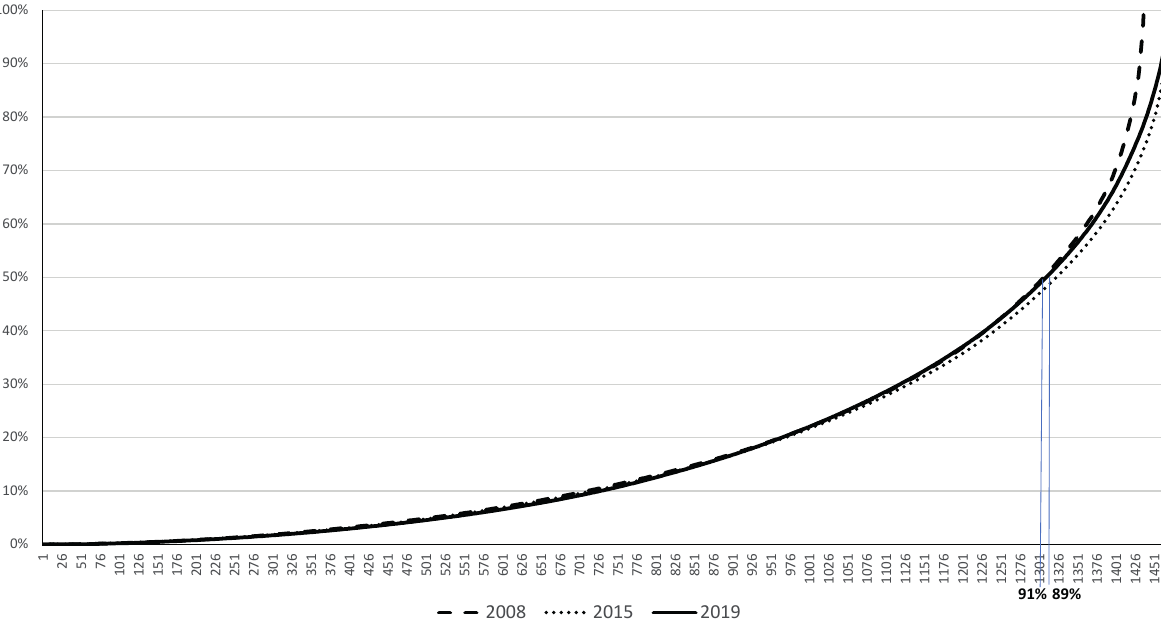
Figure A3. Lorentz curve of the (positive) farm net income within the Italian 2008-2019 FADN balanced sample: years 2008, 2015,